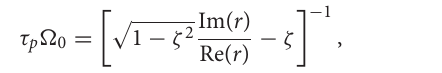
8.4 Hz for the specific nuclei to ≈ neurons in the